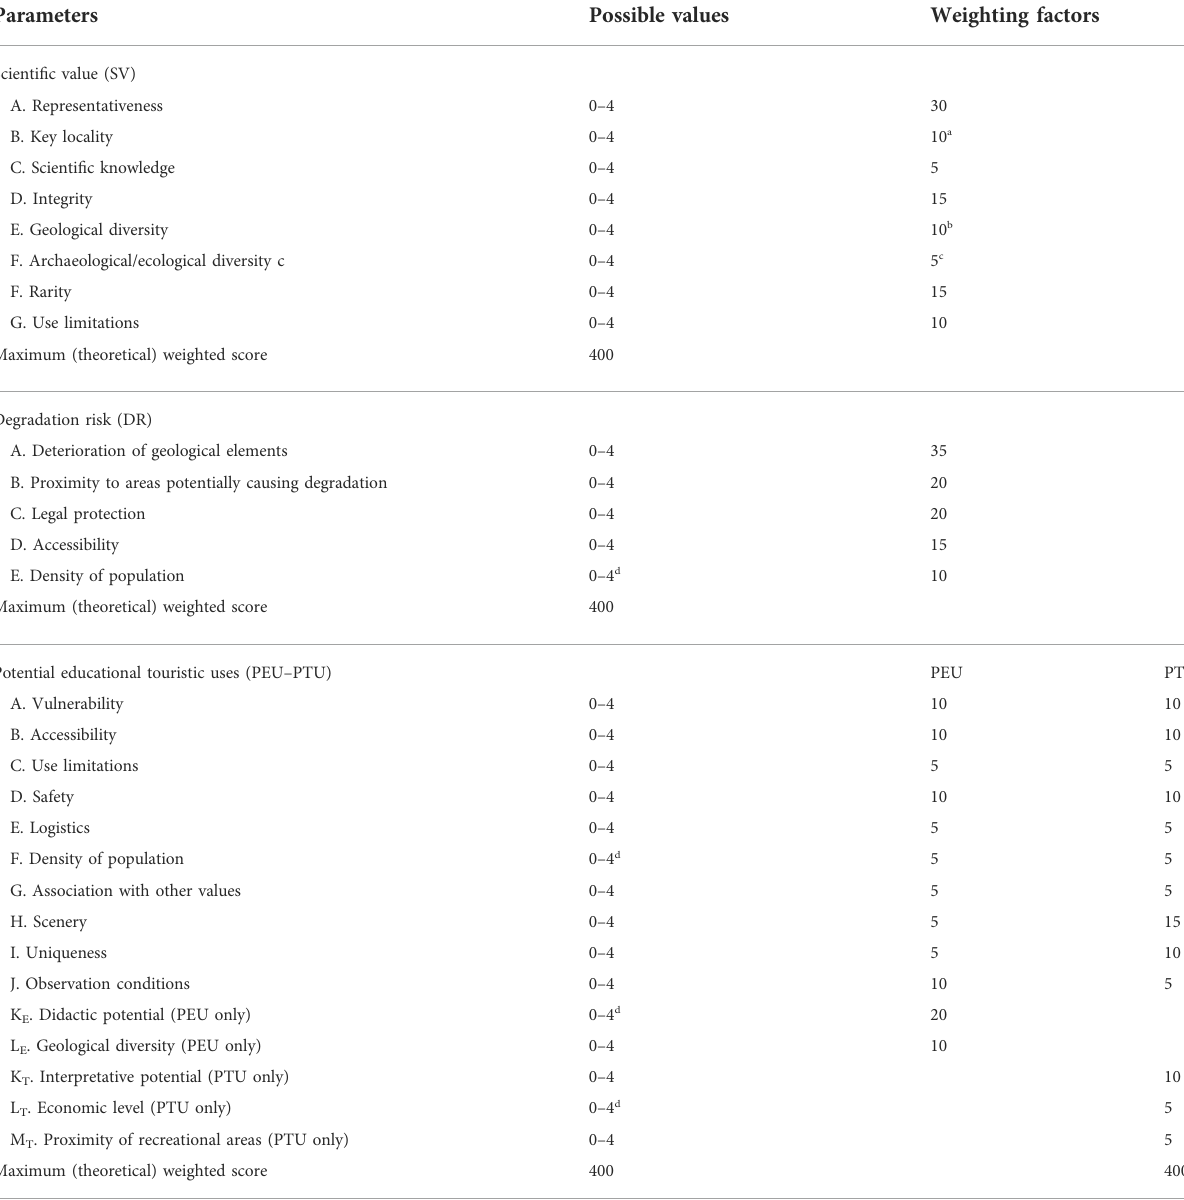
TABLE 1 Categories and parameters considered in the quantitative assessment of the geosite (modi fi ed after Brilha 2016).